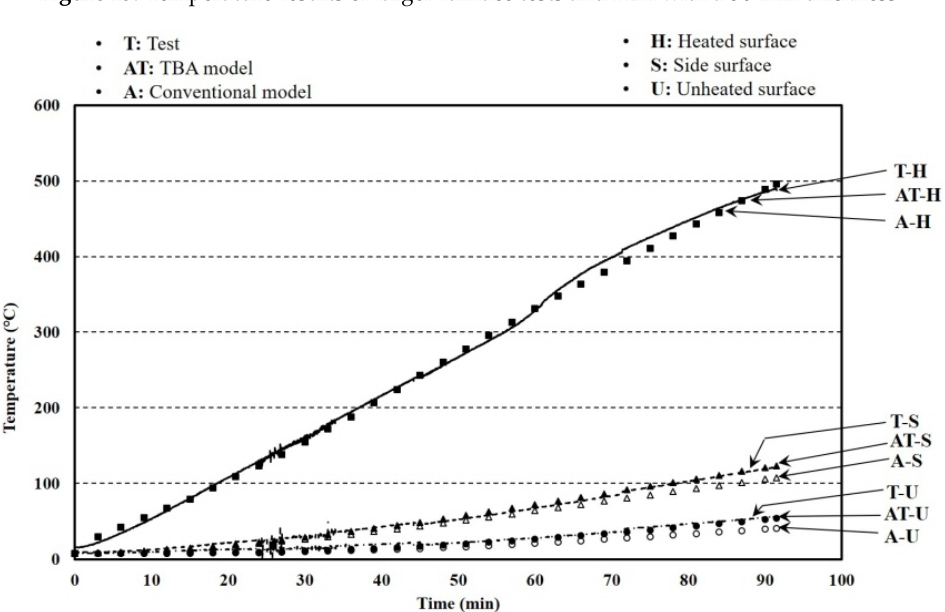
Figure 16. Temperature results of larger furnace tests and FEA with a 60-mm thickness.